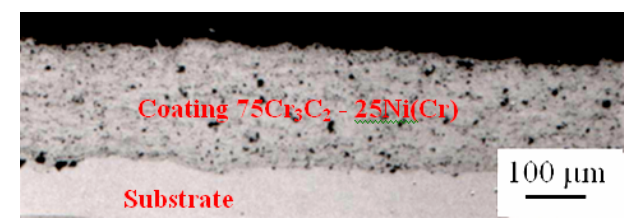
Figure 4 – 75Cr3C2 - 25Ni(Cr) coating microstructure deposited with the powder feed rate of 30 g/min Slika 4 – Mikrostruktura 75Cr3C2 - 25Ni(Cr) prevlake deponovane sa brzinom dovoda praha 30 g/min